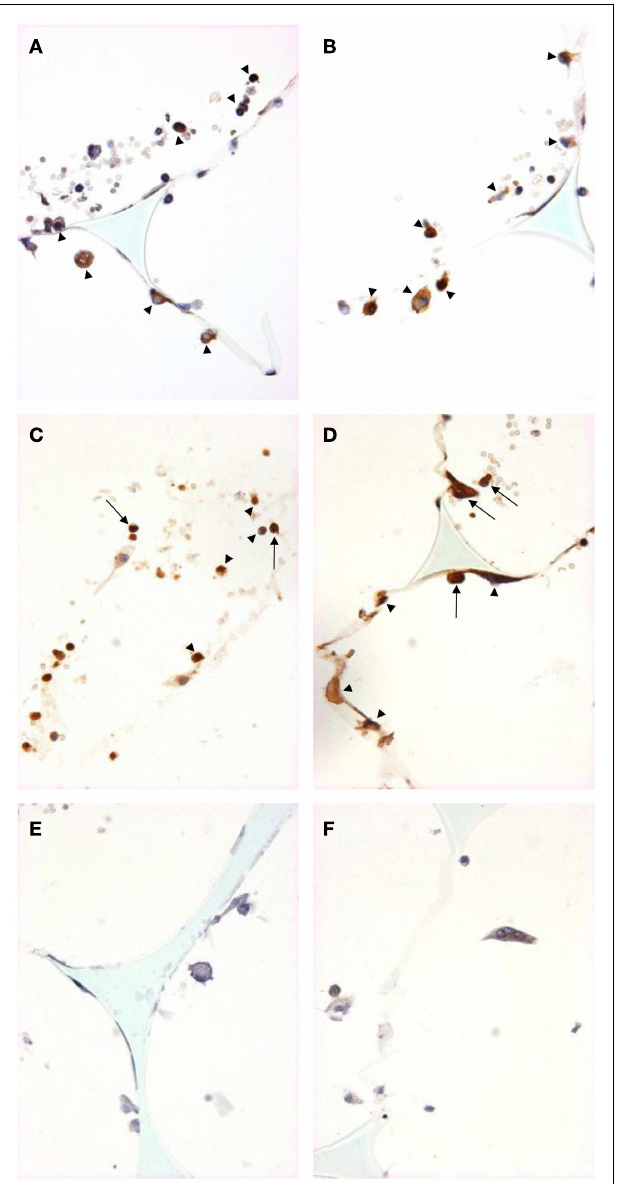
FIGURE 4 | Signal pathway activation in sponge granuloma sections fromApoE KO orApoE/Rag-1 DKO mice . Sections from ApoE KO (A,C,E) or DKO (B,D,F) mice were stained to show immunolocalization of NF- κ B (A,B) or phosphorylated STAT1 (C,D) . Control sections (E,F) were exposed to non-immune IgG. Positive staining appears brown (DAB), nuclei blue-purple (hematoxylin), and sponge spicules light blue. Sections from either mouse strain contained many cells with positive cytoplasmic staining (arrowheads). Some cells did not contain detectable levels of NF- κ B or phospho-STAT-1, while others appeared to have NF- κ B or phospho-STAT-1 present in their nucleus (arrows) (Magnification: × 600).